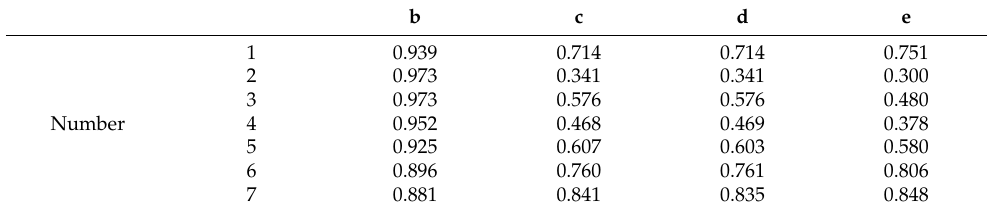
Table 2. SSIMs between the original images and the resulting images with respect to Figure 6.